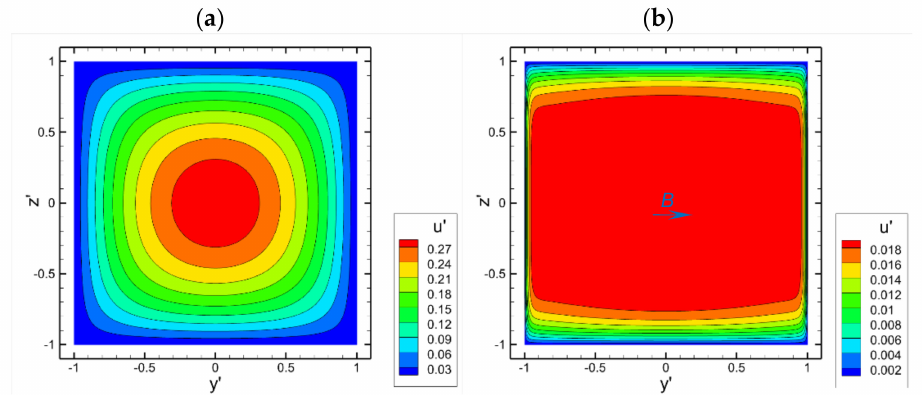
Figure 3. Distribution of the non-dimensional axial velocity u (cid:48) in a constant x (cid:48) plane for Ha channel = 0 ( a ) and Ha channel = 50 ( b